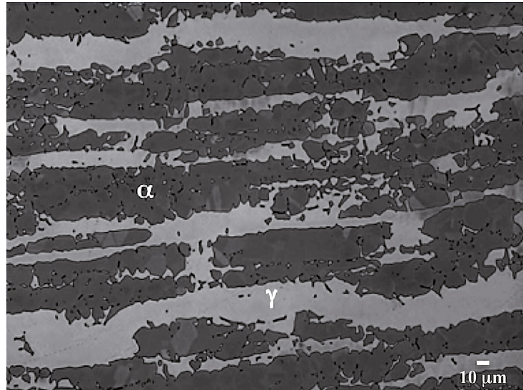
Figure 1. Microstructure of UNS S32750 superduplex stainless steel in the as-received condition.